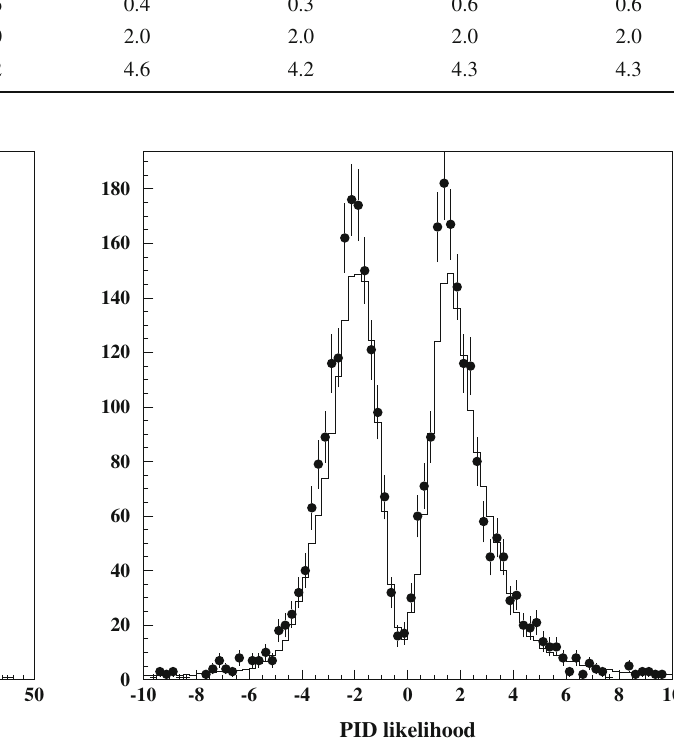
Fig. 30 Ring counting likelihood distribution for SK-2 atmospheric fully contained neutrino events. Closed circle is data and histogram is the MC expectation normalized live time with neutrino oscillation. Events with Likelihood < 0 are assigned to be 1 ring